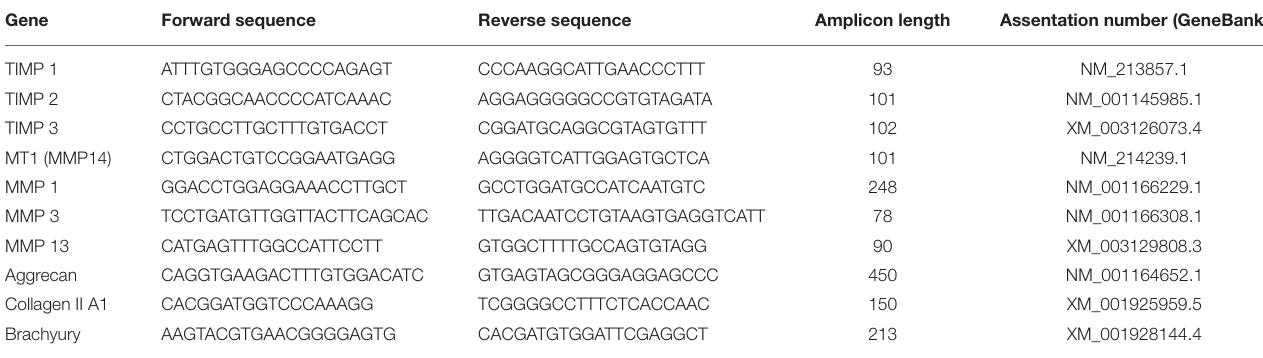
TABLE 1 | List of studied genes a